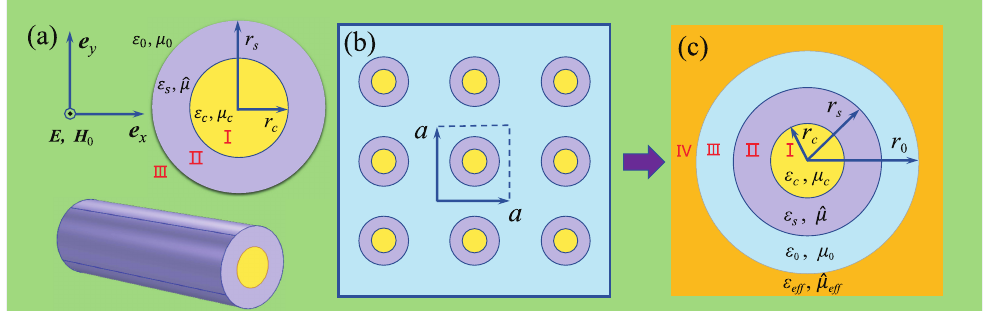
Figure 1. The schematic diagram illustrating the geometry of a DCL ferrite rod in air background under the illumination of an electromagnetic wave with TM polarization ( a ), the composite MM made up of an array of DCL ferrite rods arranged periodically as a square lattice in the air ( b ), as well as the transformation of a unit cell in panel ( b ) into a TL hybrid rod ( c ) in effective-medium